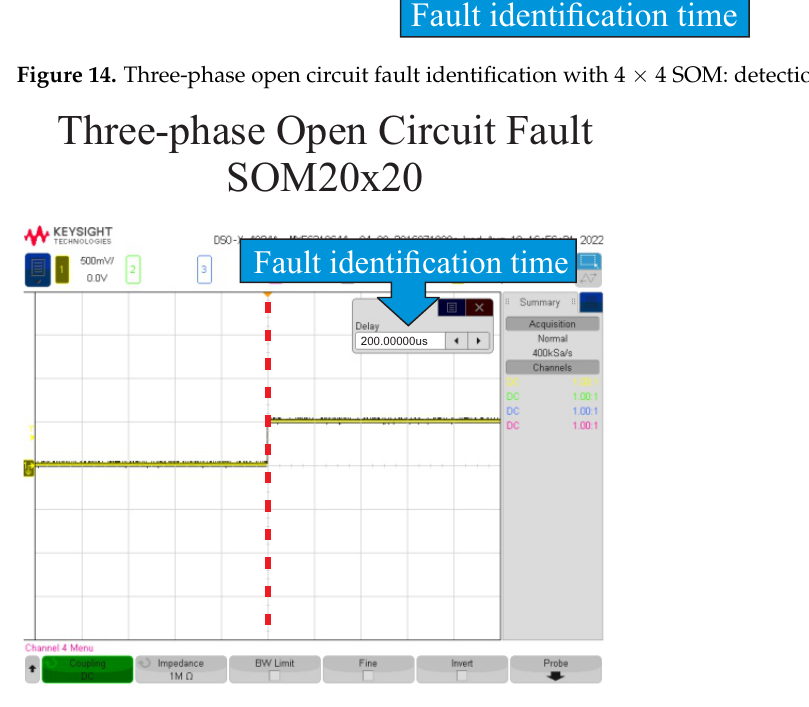
Figure 15. Three-phase open circuit fault identification with 20 × 20 SOM: detection time 200 µ